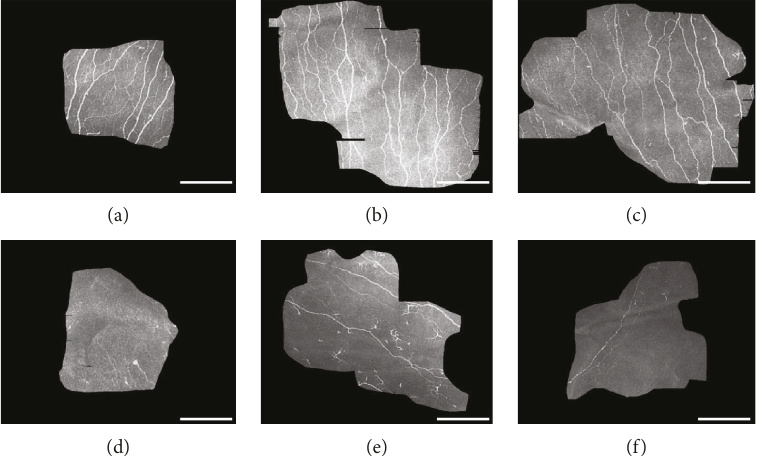
Figure 3: Confocal images demonstrating the morphology of SBN from 3 control subjects (a, b, c) and from 3 Charcot subjects (d, e, f). (d, e, f) Exhibited readily visible changes with decrease in nerve fi bers, decrease in nerve branches and connectivity, and abnormal presence of widely scattered dendritic cells (e). Each scale bar represents 200 μ m.